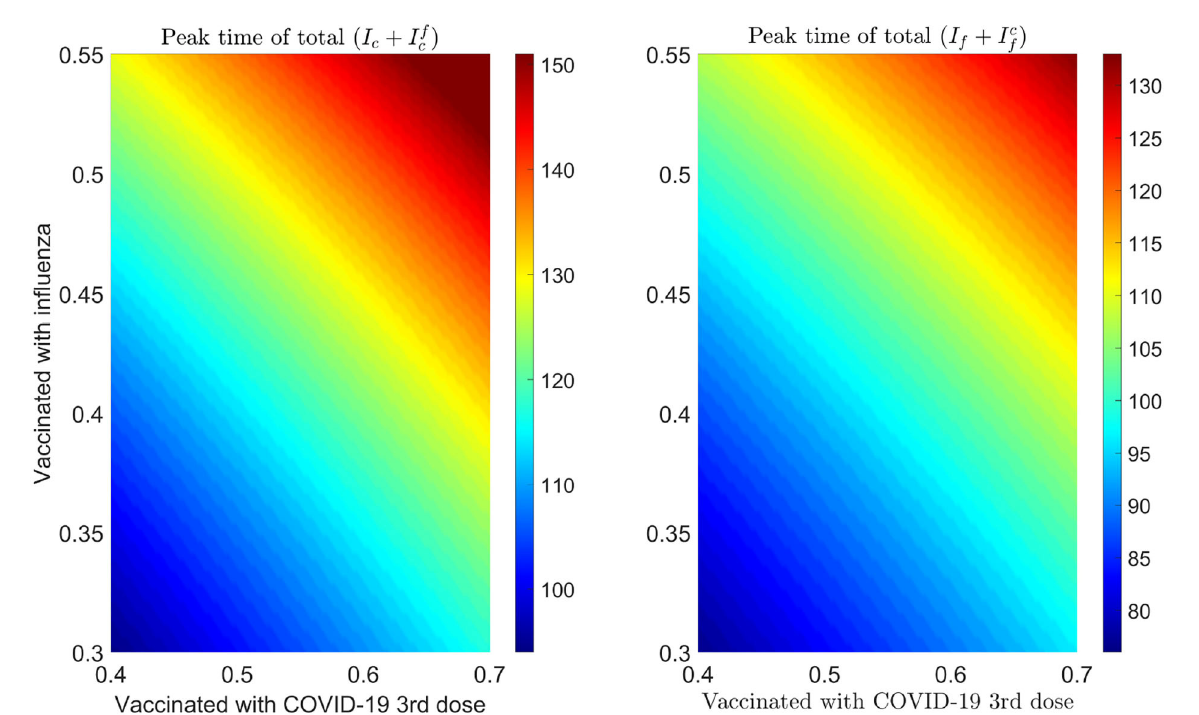
FIGURE10 Impact of increasing proportion of individuals vaccinated with the first booster dose of COVID-19 and influenza vaccines on the peak time of infections. Left plot represents the total number of infections with COVID-19 ( I c ( t ) + I f c ( t )) and right plot shows the total number of infections with influenza ( I f ( t ) + I c f ( t